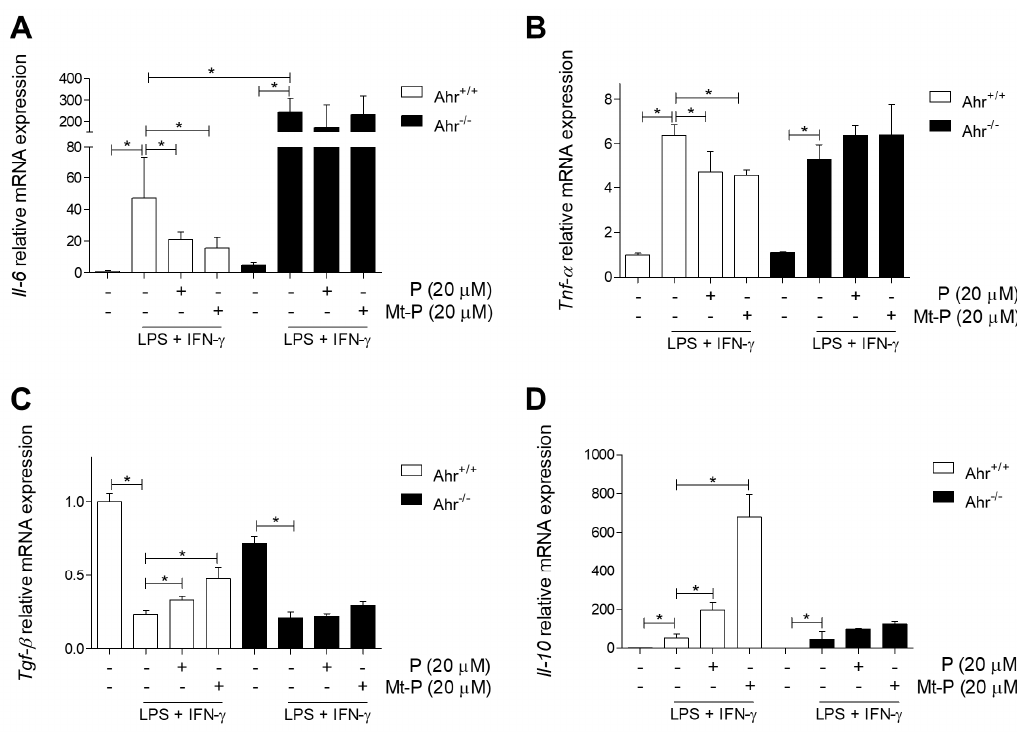
Figure 2. P and Mt-P counteracts in vitro macrophages immune activation through the AhR. The experiment was carried out on macrophages purified by the spleen of AhR +/+ and AhR − / − mice. Macrophages cells were primed 16 h with LPS (5 ng / mL) / IFN- γ (20 ng / mL) alone or in combination with P (20 µ M) and Mt-P (20 µ M). At the end of stimulation, the relative mRNA expression of pro-inflammatory cytokines ( A ) Il-6 and ( B ) Tnf- α , and anti-inflammatory cytokines ( C ) Tgf- β and ( D ) Il-10 , was assessed by Real-Time PCR. Values are normalized relative to Gapdh mRNA and are expressed as mean ± SEM ( n = 4); * p < 0.05.